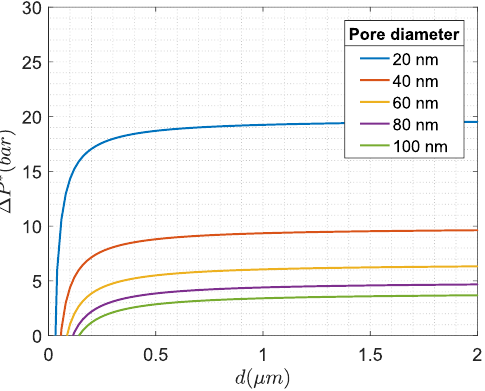
Figure 3. Required pressure to force a droplet with specific size through five different pore